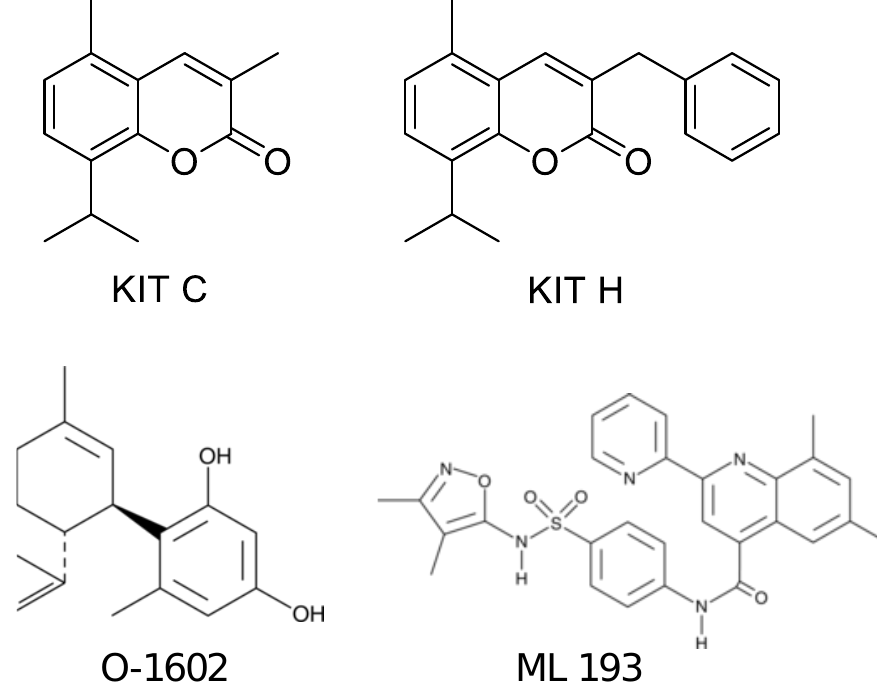
Figure 9. Chemical structures of KIT C, KIT H, O-1602, and ML 193 as previously published [17], respectively, as provided by the Cayman Chemicals website (https://www.caymanchem.com (accessed on 6 January 2022)).